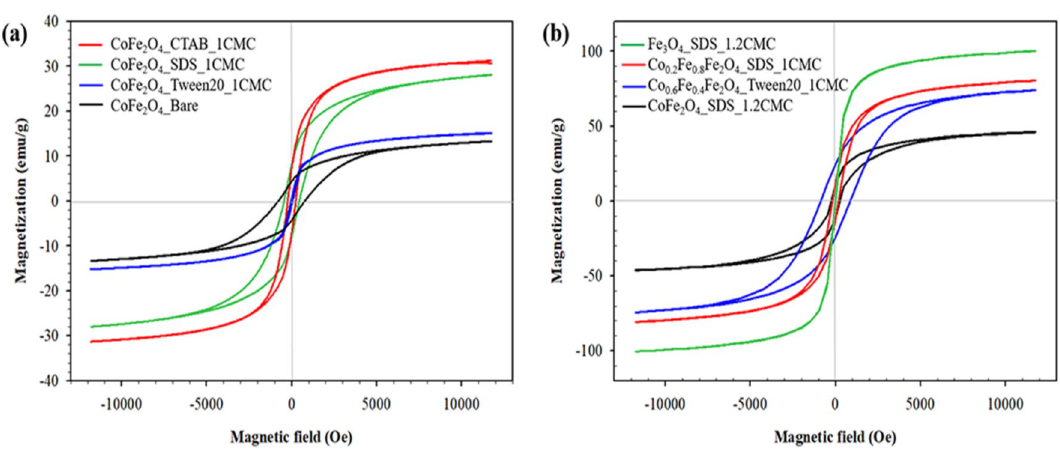
Figure 8. Hysteresis loops of CoFe 2 O 4 and Co x Fe 1−x Fe 2 O 4 : ( a ) under various surfactant types; ( b ) under various Fe 2+